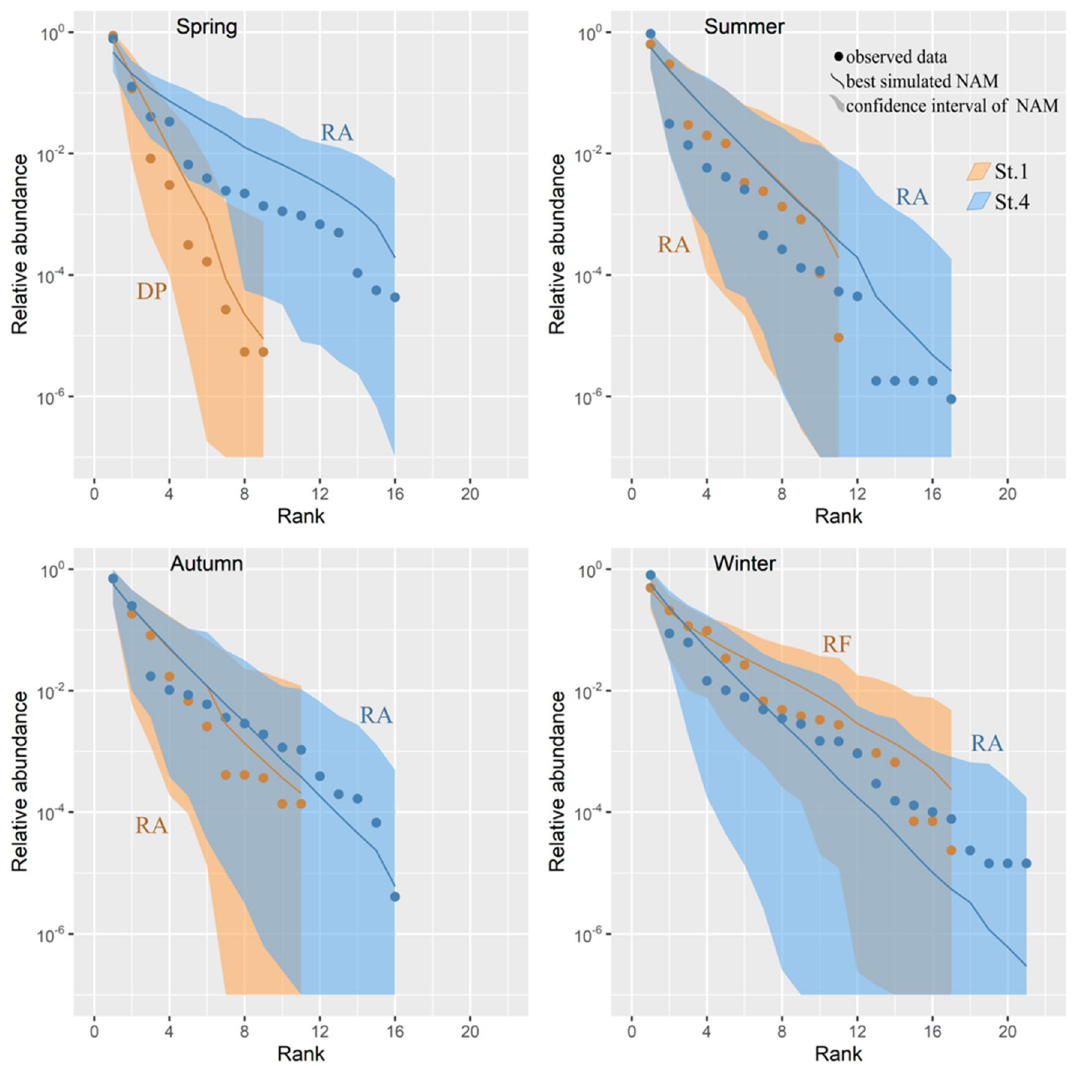
Figure 6. Best fitting Niche Apportionment Models for different seasons at St.1 and